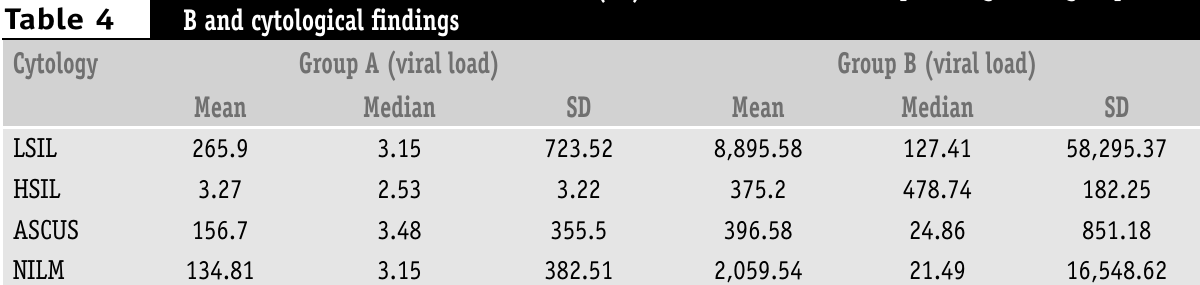
Mean, median and standard deviation (SD) of the viral load to samples reagent to group A or B and cytological